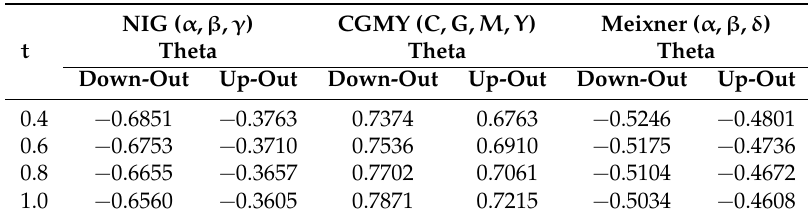
Table 5. Change of Theta over Time to